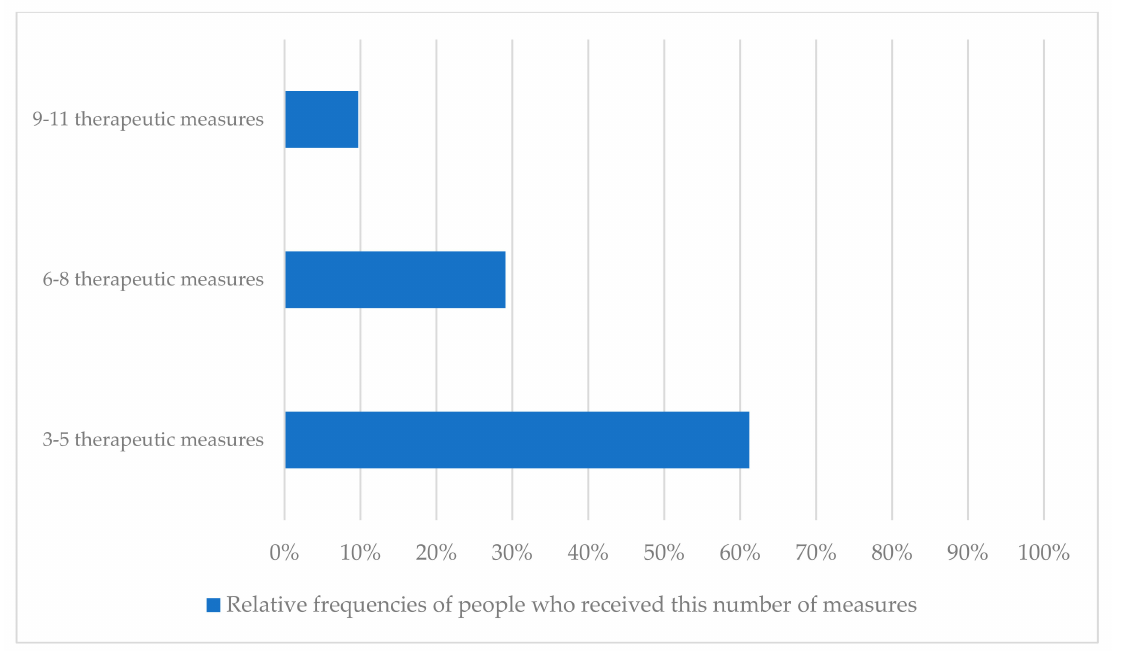
Figure 4. Relative frequencies of people who received 3–5, 6–8, or 9–11 therapeutic measures in the last half year.